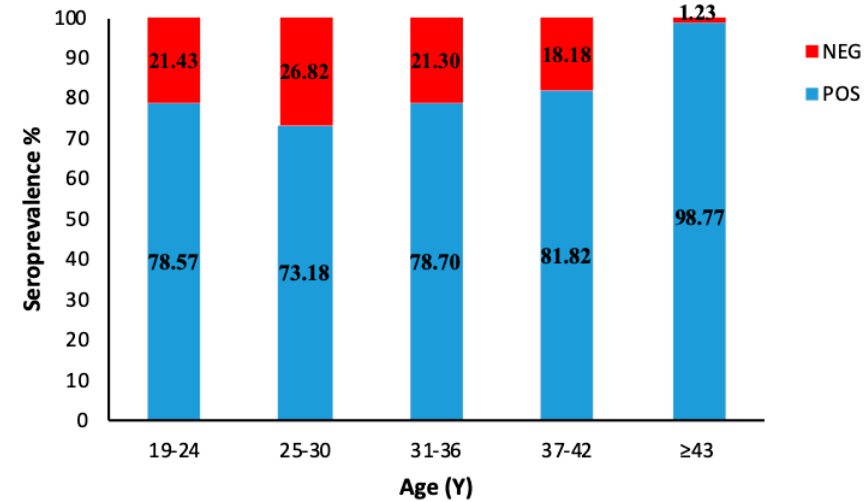
Figure 2. Age-specific measles IgG prevalence categorized into different age groups. Subjects over 43 years old were included into the same group.